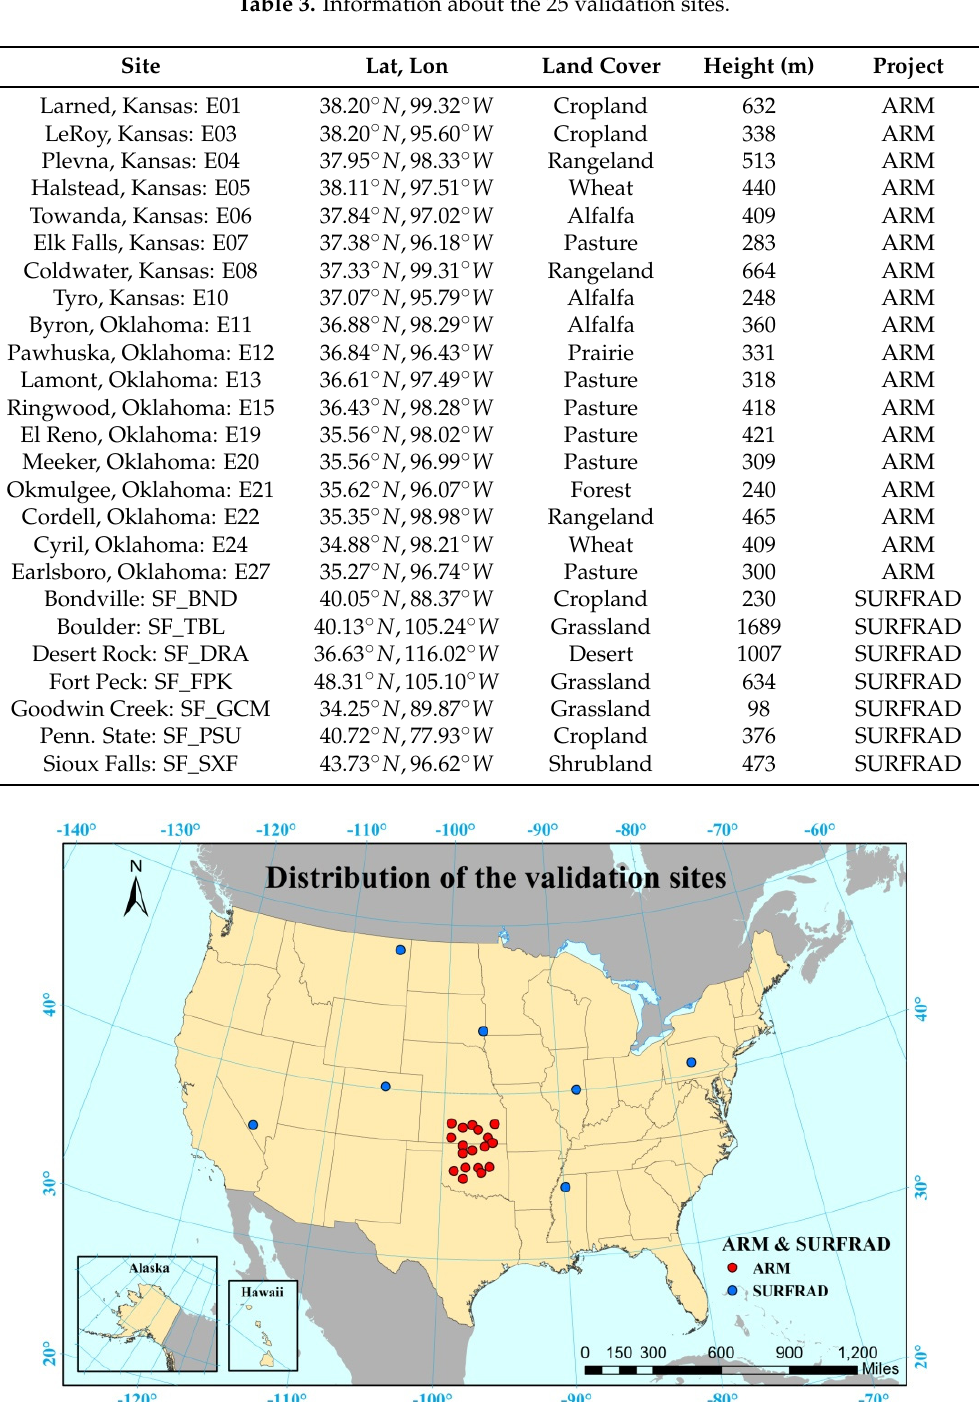
Table 3. Information about the 25 validation sites.